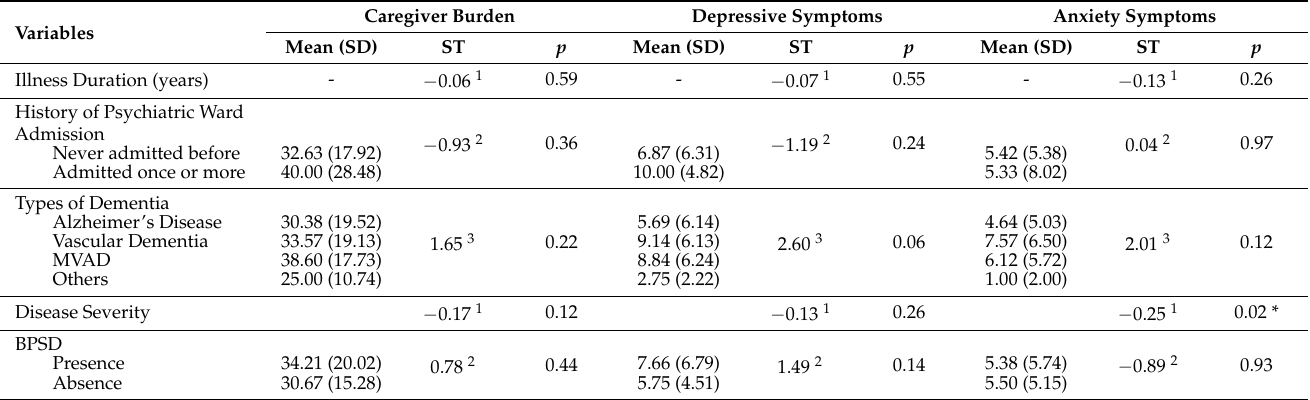
Table 8. Relationships between Patient Illness Characteristics and Caregiver Burden, and Depressive and Anxiety Symptoms in Caregivers of